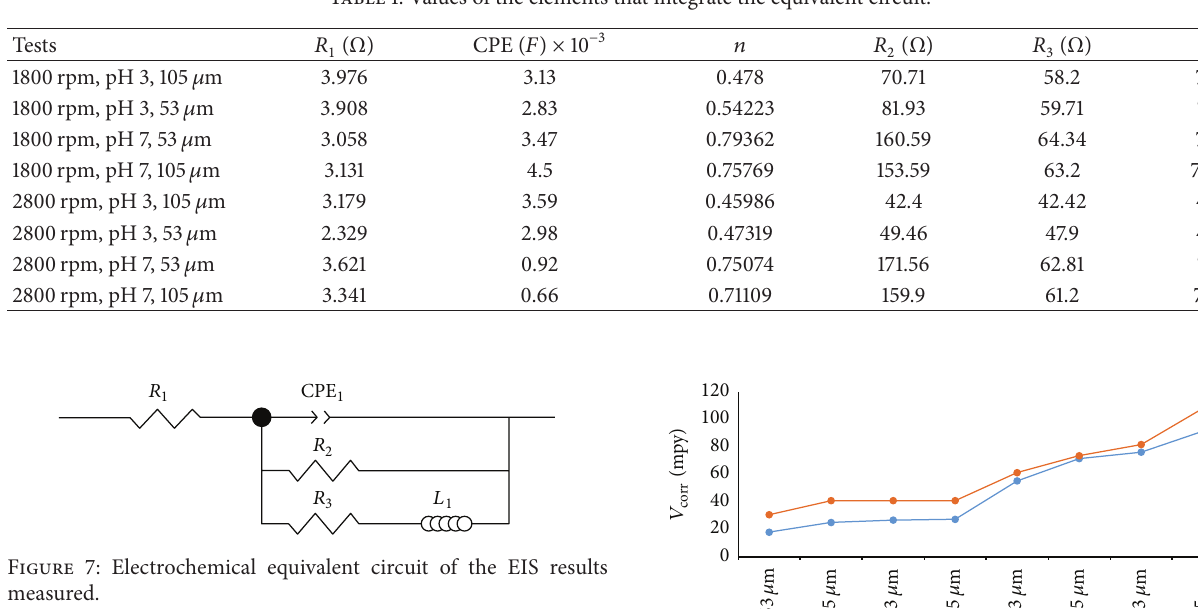
Table 1: Values of the elements that integrate the equivalent circuit.